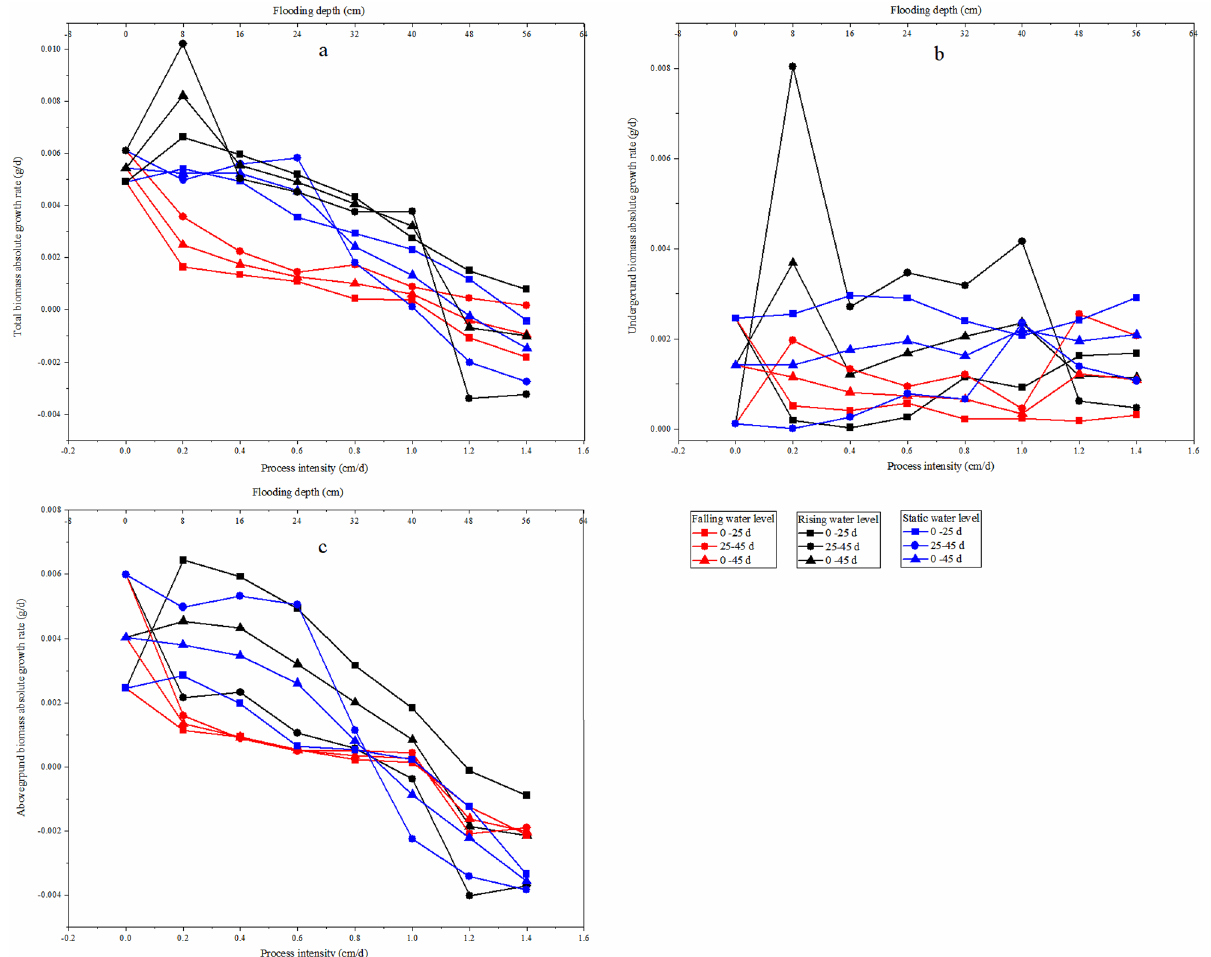
Figure 7. Effect of different hydrological environments on the absolute growth rate of the biomass of C. cinerascens. ( a ) Total biomass absolute growth rate. ( b ) underground biomass absolute rate. ( c ) aboveground biomass absolute rate.